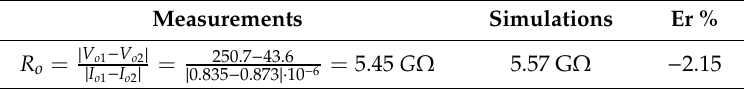
Table 5. Empirical verification of the methodology. PIC700 lead-free material.